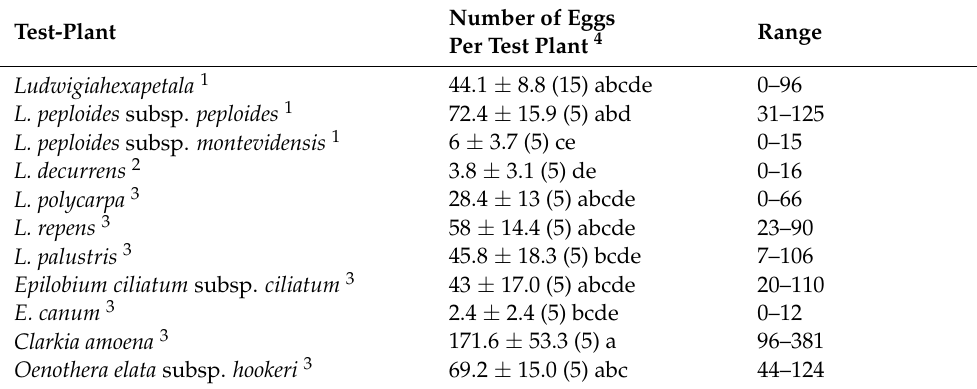
Table 2. Mean ± 1SE ( n ) eggs oviposited by Lysathia flavipes on exotic Ludwigia and native test plant species in multiple-choice host range